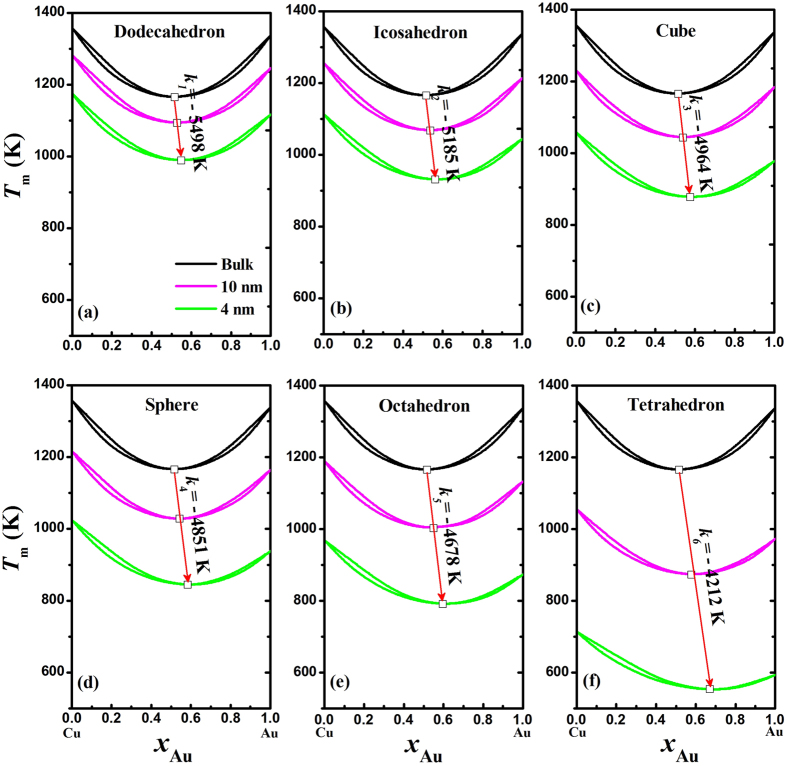
Phase diagrams of Cu-Au alloys at bulk, 10 nm, and 4 nm, where the symbol (□) denotes the congruent melting point and the arrow highlights the size and shape effects on the congruent melting point.